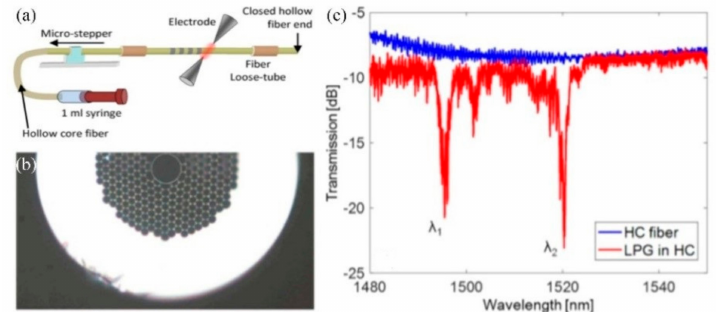
Figure 20. ( a ) Schematic diagram; ( b ) microscopy image; and ( c ) transmission spectra of the SLPFG in air-core PBF by using the pressure-assisted arc discharge heating technique